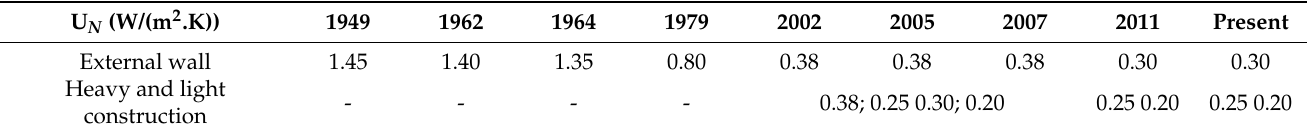
Table 2. Development of the standard value of the U N (W/m 2 .K)) coefficient for the design temperature of θ im = 20 ◦ C according to ˇCSN 73 0540 code for heavy construction and light construction [40,41]. U N (W/(m 2 .K))